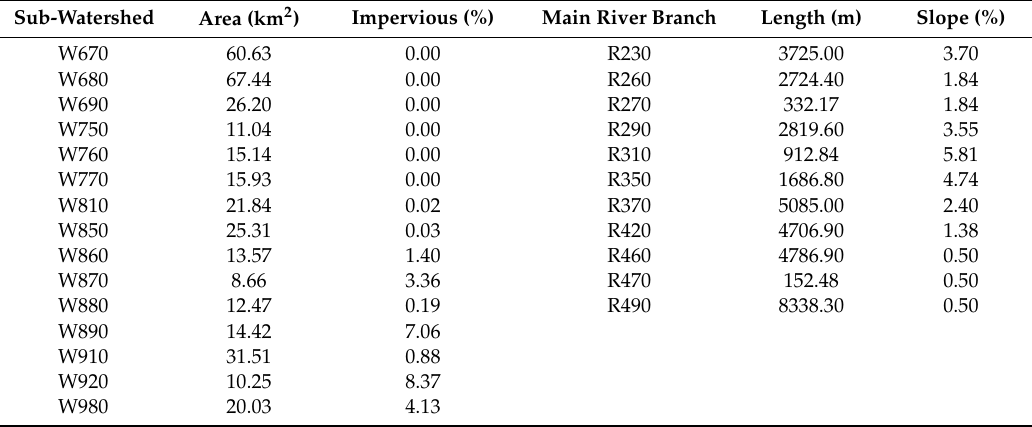
Table 3. Statistical description of the 15 sub-watersheds and main river